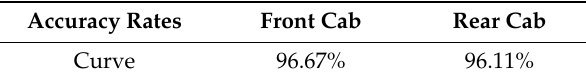
Table 9. Accuracy rates at each speed.